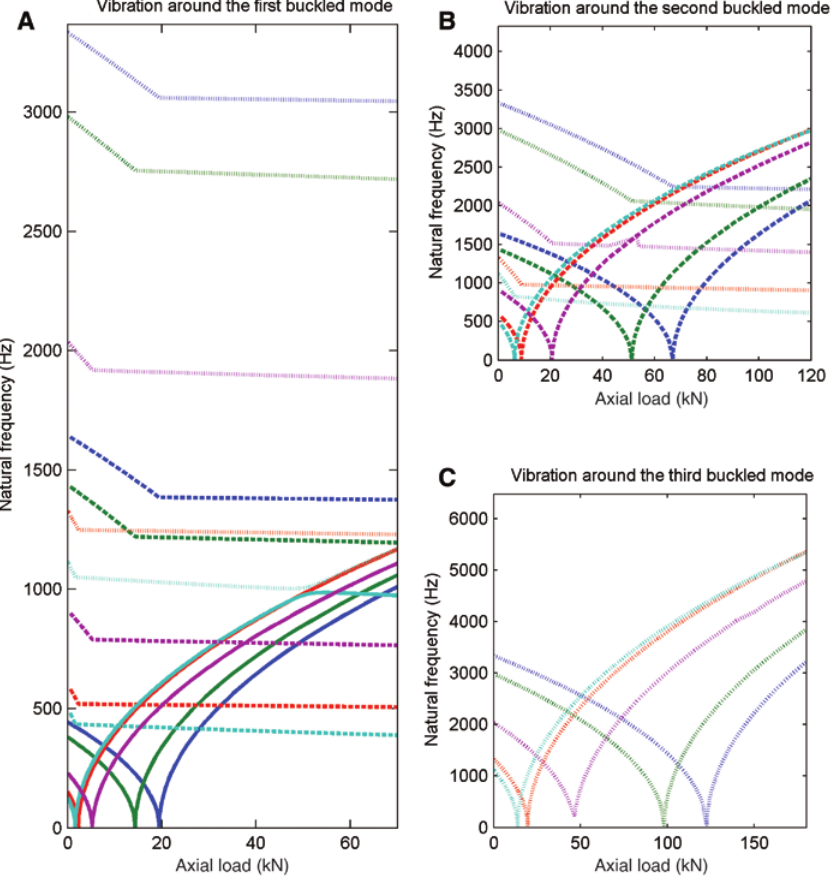
Figure 7 Variation of the natural frequency around the first three buckled configurations with the applied axial load for different laminates of an SS